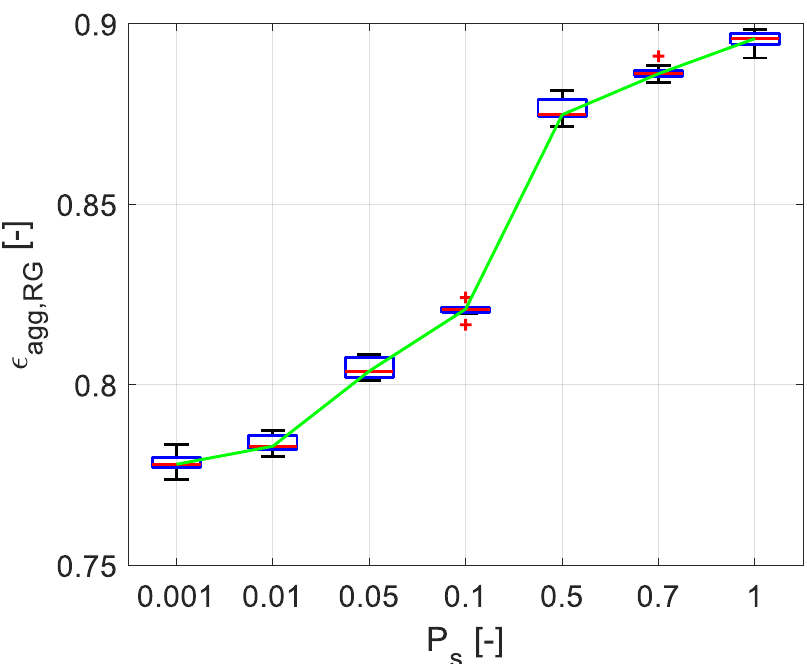
Figure 3. Porosity obtained from the radius of gyration method for agglomerates generated by employing the sticking probability model at different sticking probabilities (P s